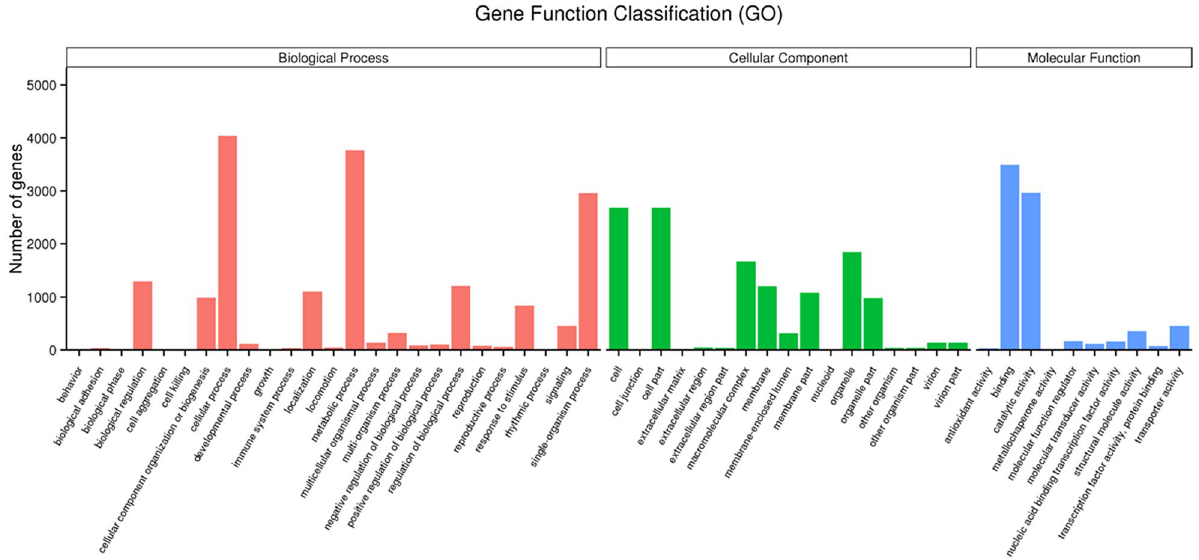
Figure 2. Gene ontology (GO) classification of P.polysora unigenes. A total of 6603 unigenes with significant similarity in Nr database categorized into three main GO